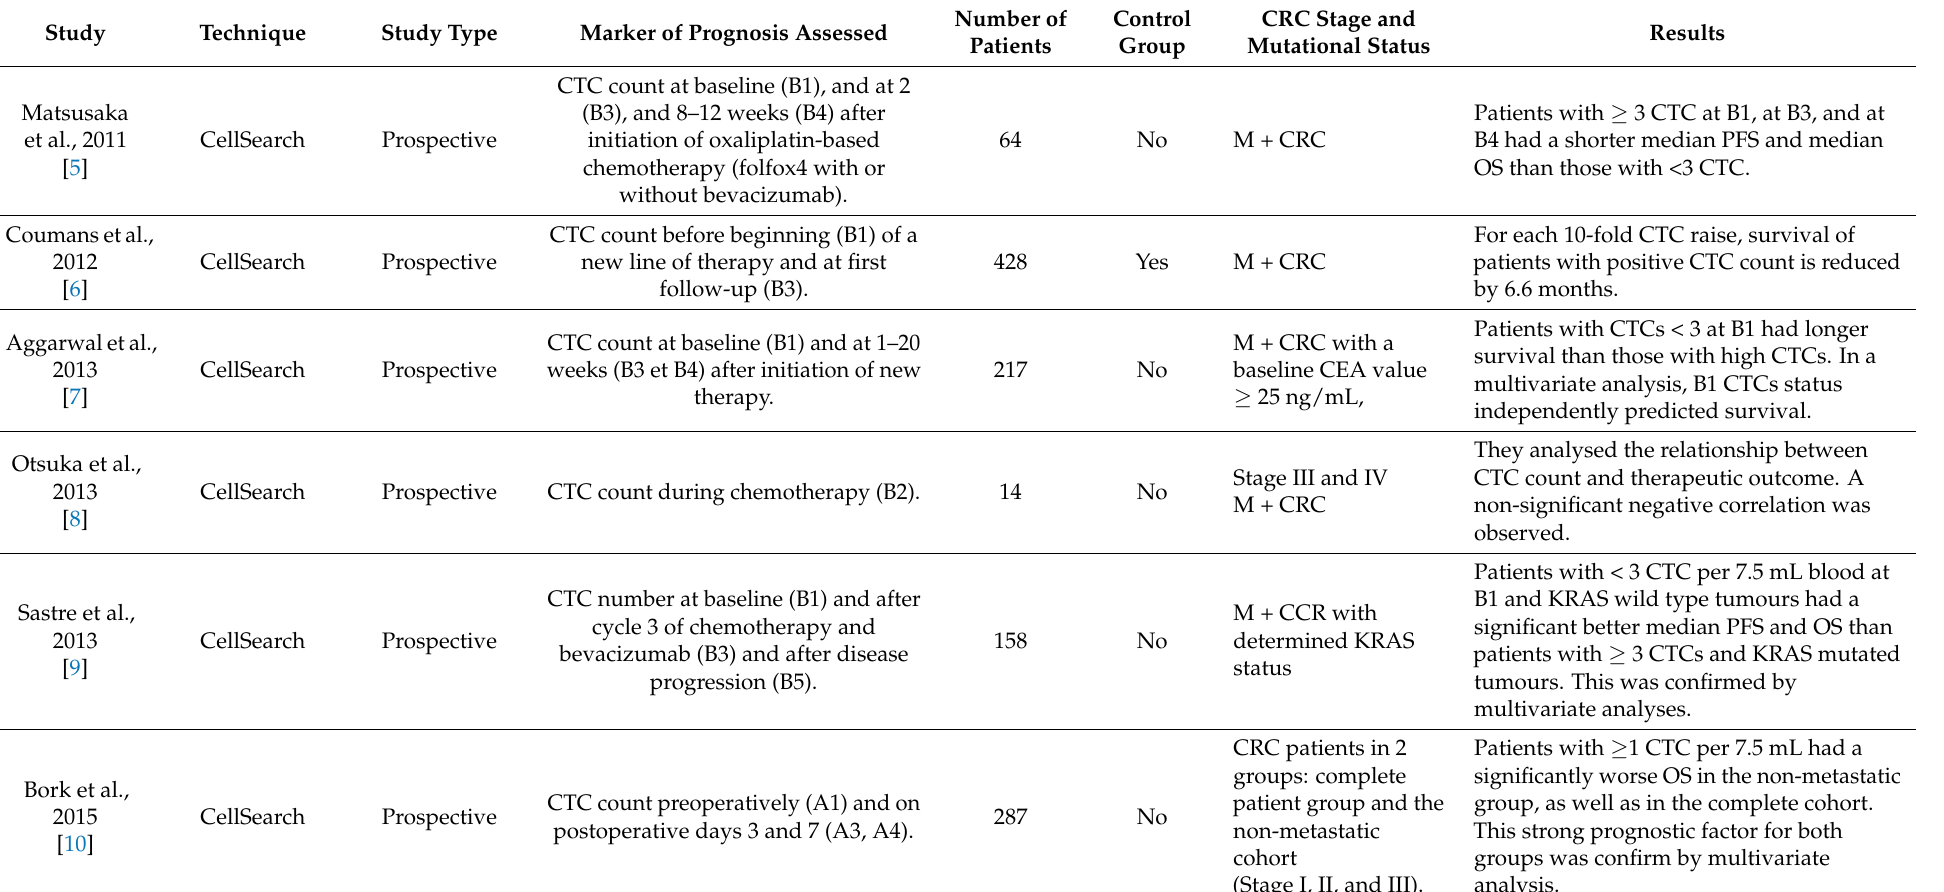
Table 3. Summary of quantitative included studies, separated into categories according to